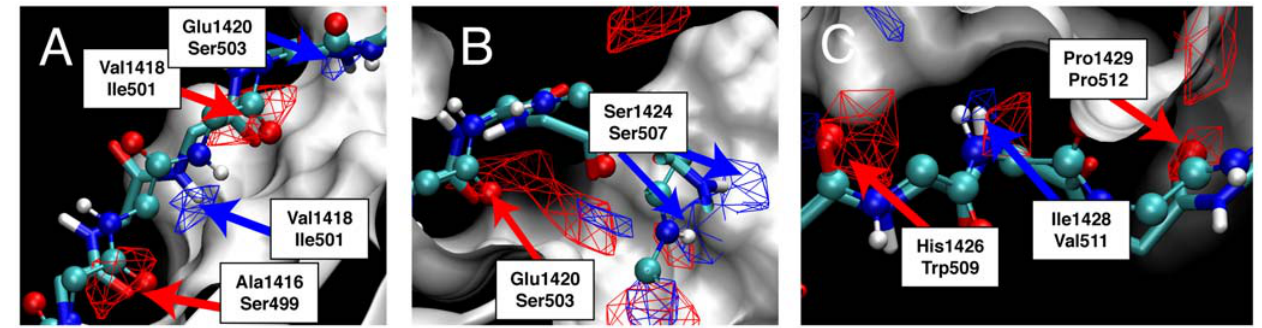
Figure 4. Hydrogen bond donor (blue mesh) and hydrogen bond acceptor (red mesh) SILCS FragMaps isosurfaces overlapping with the (A) N-terminal, (B) central, and (C) C-terminal residues in the SMRT and BCOR peptides. SMRT peptide atoms are represented as balls- and-sticks and BCOR atoms as tubes. The BCL-6 molecular surface from the BCL-6:SMRT complex is also shown, and the residue/FragMap overlaps are labeled.